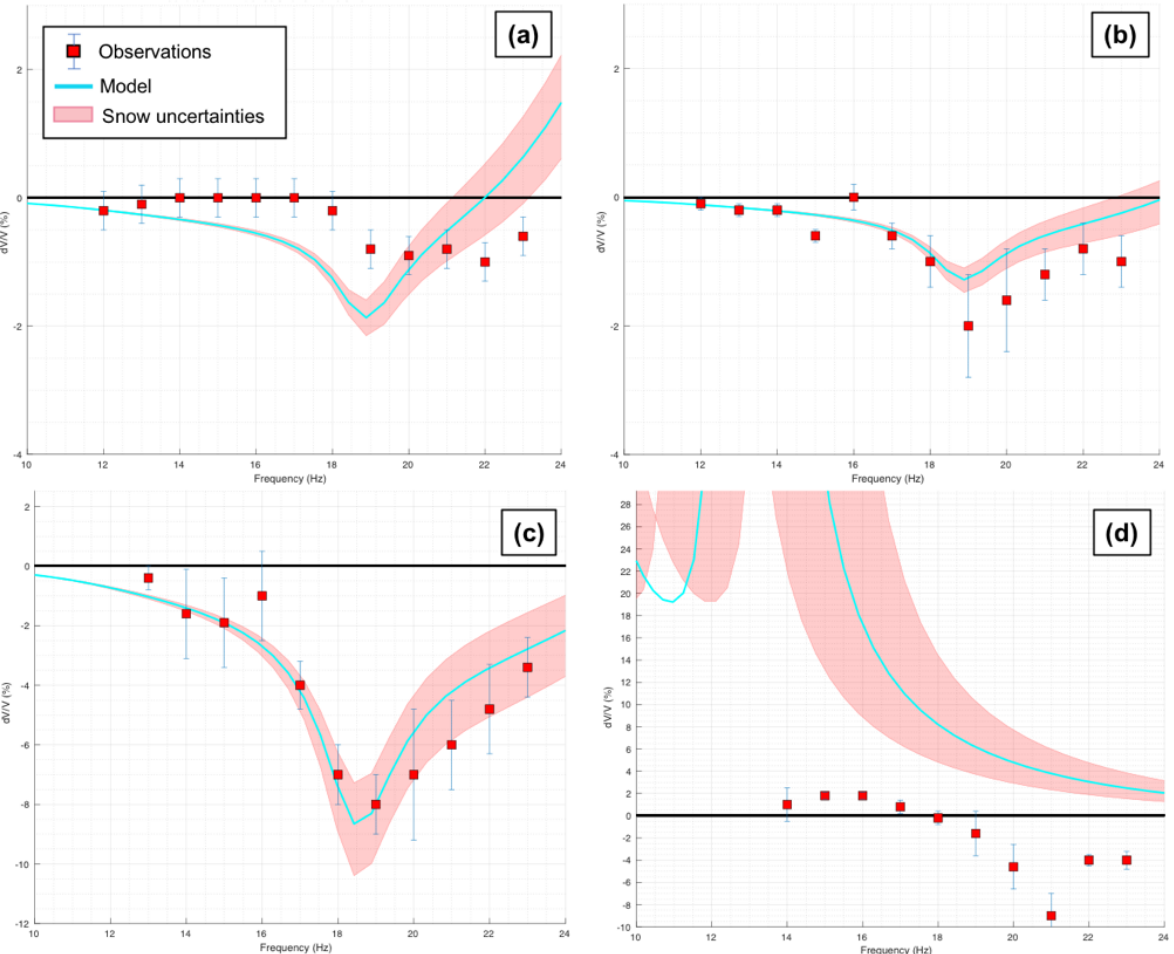
Figure 12. (a) Results of the d V/V modeling for snowfall event 0 (SF0), with the modeled d V/V response with respect to frequency (blue curve) and uncertainties (shaded pink curves) related to ± 10% variations in snow elastic parameters. Observations are highlighted in red squares, whose frequency is fixed to the center of the frequency band of the measured d V/V . (b) Same legend for snowfall event 1 (SF1). (c) Same legend for snowfall event 2 (SF2). (d) Same legend for snowmelt event 0